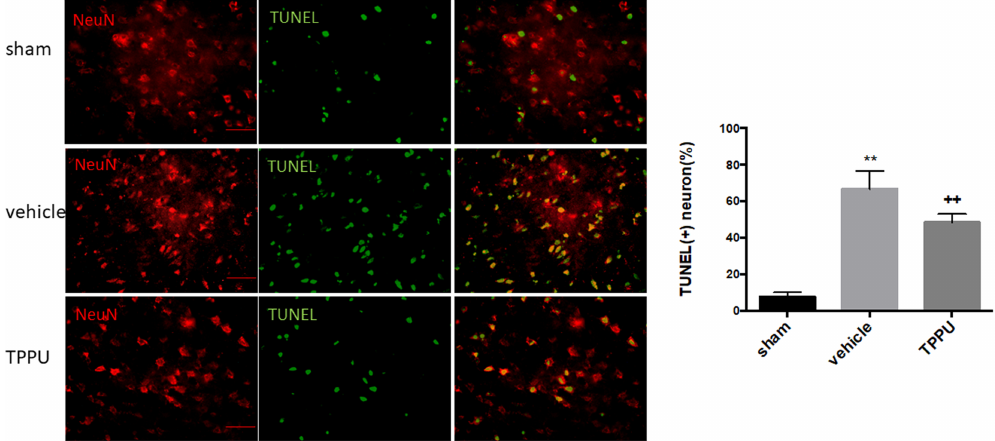
Figure 5. TPPU decreases peri-infarct neuronal cell death. Neuronal cell death in the ipsilateral cortex at 2 d after surgery was detected by terminal deoxynucleotidyl transferase dUTP nick end labeling (TUNEL, green) and NeuN (red) double staining. Scale bar = 50 μ m. Sham, MCAO with vehicle, and MCAO with TPPU groups were compared by ANOVA and the Holm-Sidak procedure for multiple comparisons (means ± SD; n = 5 rats per group; * * p < 0.01 vs. sham group, ++ p < 0.01 vs. vehicle group).